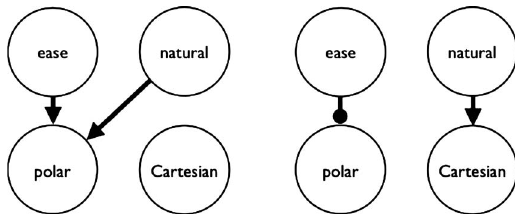
FIG. 9. Resource graphs of Wes and Derek for the week 10 miniview. Note the explicit lack of connection between ease and polar resources for Wes but not for Derek.